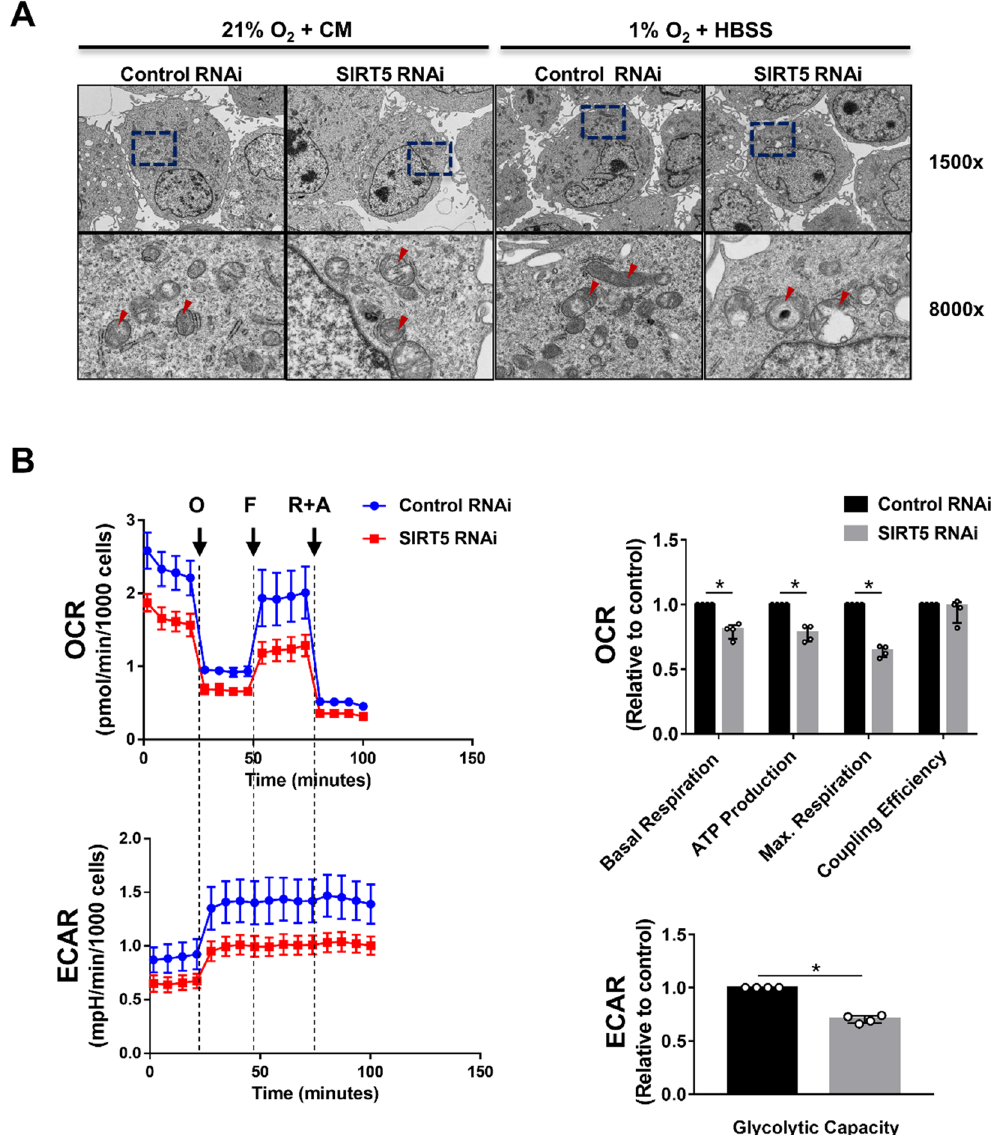
Figure 5. SIRT5-depletion exacerbates OND-induced bioenergetic dysfunction. hPTECs were transfected with siRNA against SIRT5 or non-targeting siRNA control. Seventy-two hours post-transfection cells were exposed to 6 h of oxygen and nutrient deprivation (OND) (1%O 2 + HBSS) or normoxia and complete medium (21%O 2 + CM). ( A ) TEM images showing mitochondria (red arrows). Magnification: ×1500 and ×8000. Lower panels show higher magnification of the area indicated by blue squares. ( B ) Summary of Seahorse XFp Mito Stress Test assay of cells exposed to 6 h OND. Representative profile of Mito Stress Test data showing oxygen consumption rate (OCR) and extracellular acidification rate (ECAR) with arrows indicating injection of the specific stressors oligomycin (O), FCCP (F) and Rotenone plus antimycin A (R + A). Relative values of the parameters normalized to the non-targeting siRNA control. Data are from four independent experiments with n = 3 technical replicates/group. Wave software (Agilent) was used for data analyses. Mann–Whitney U test was used to determine statistical significance. Data are median ± IQR. *p <